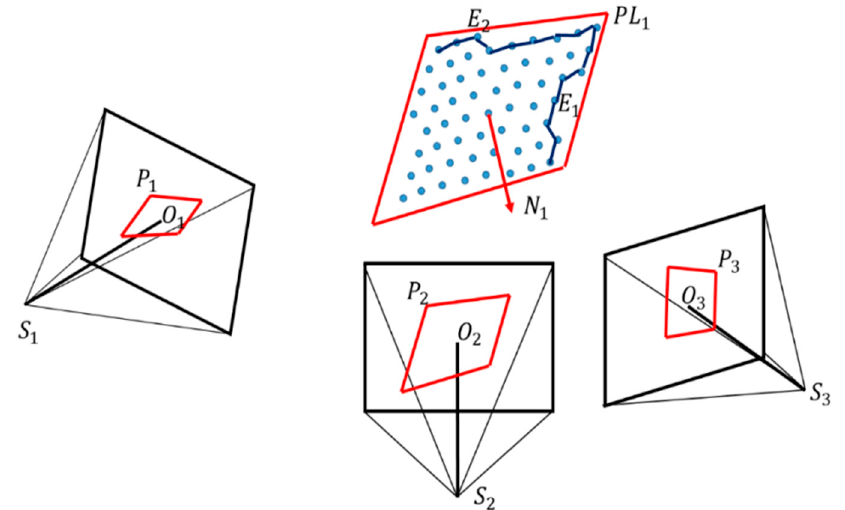
Figure 2. Illustrations of the extracted edge from point clouds and image selection. P 1 , P 2 and P 3 indicate the projection area of segmented plane PL 1 . The images S 2 and S 3 have the biggest projection polygon area, and they accordingly are chosen for feature line extraction.